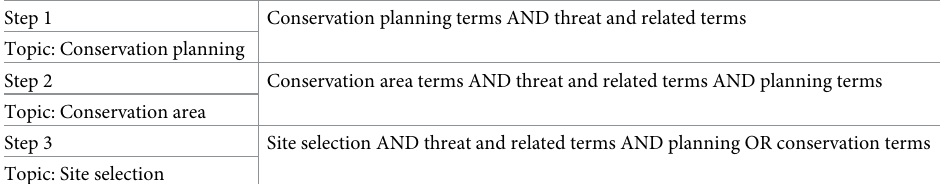
Table 3. Search steps and phrases based on keywords.